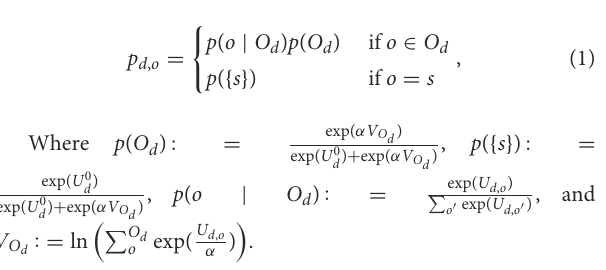
TABLE 1 Examples of evaluating probabilities p d , o with O d = { o 1 , o 2 } , α = 1 under different four ( x d , o